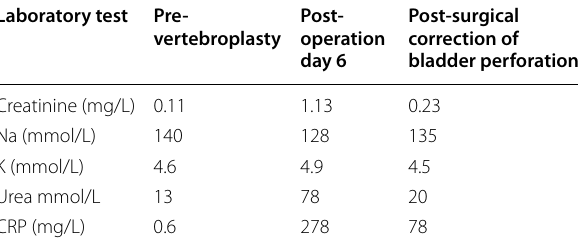
Table 1 Laboratory tests. Laboratory tests showing the abnormal values after her vertebroplasty and the decrease after her exploratory laparotomy